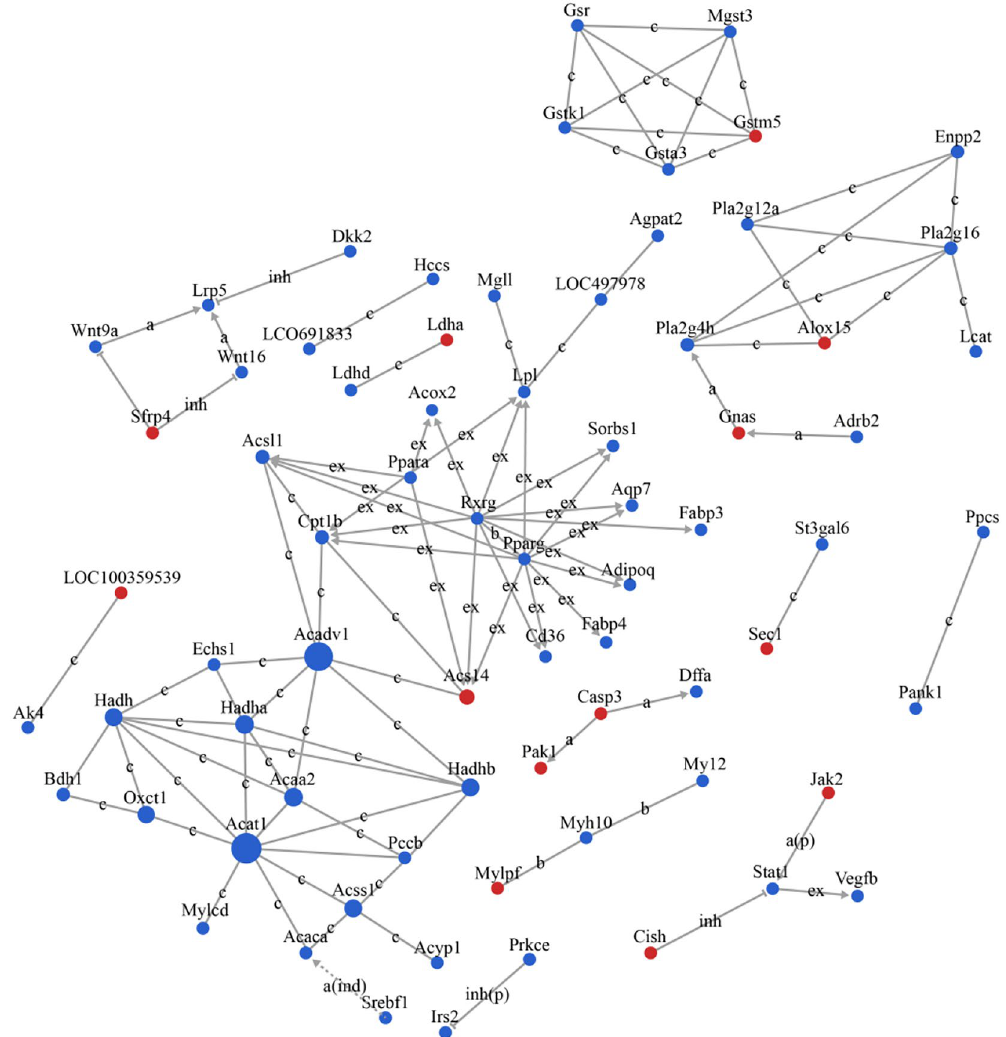
Figure 3. Network diagram of the relationship between 72 hub genes selected from gene signal network analysis. Each dot in the figure represents a gene. Larger points indicate greater betweenness values and greater importance. Red dots represent upregulated genes and blue dots represent downregulated genes. Lines indicate interaction between two genes, and the labels are the abbreviations of the type of interaction between the two genes (compound: c, active: a, indirect: ind, inhibition: inh, expression: ex, binding: b). Solid lines without arrows indicate non-directional interaction. Solid arrows indicate directional interaction, with the upstream gene at the start of the arrow and the downstream gene at the end of the arrow. Dotted arrows indicate directional interaction, with the upstream gene at the start of the arrow and the downstream gene at the end of the arrow, but the relationship between the two is indirect. Solid lines with flat heads indicate directional interaction, with the upstream gene at the start and the downstream gene at the end, with the upstream gene having an inhibitory effect on the downstream